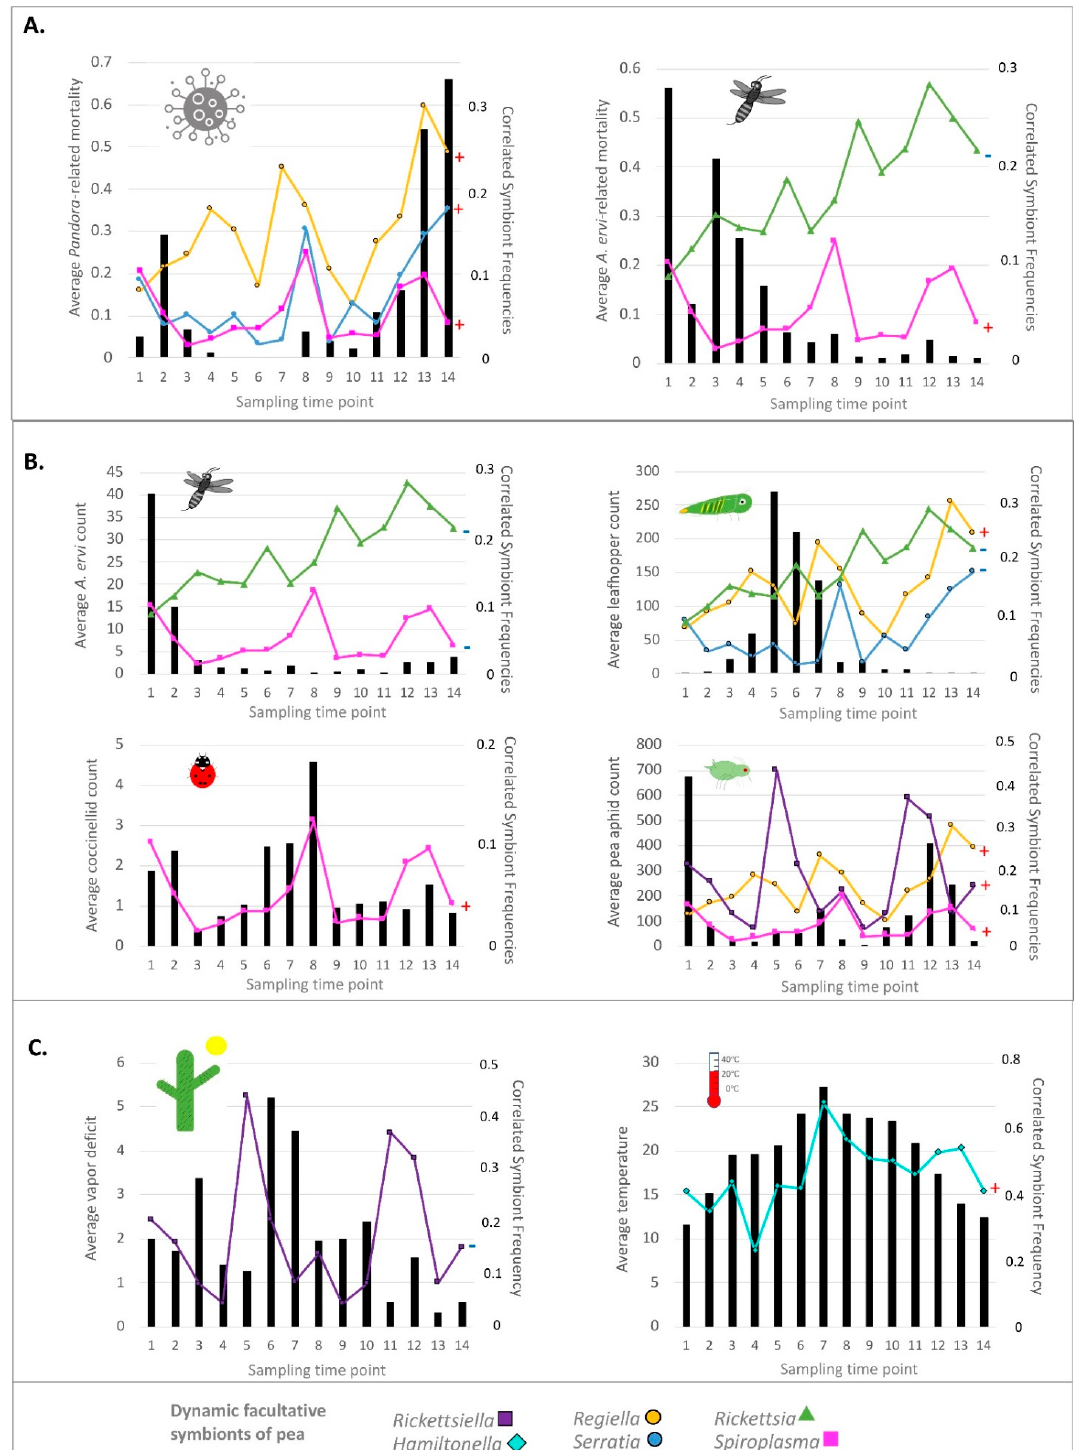
Figure 2. Correlations between the prevalence of facultative symbionts and environmental variables across the 2012 field season. Here we graph all significant results from our assessments of whether environmental variables (time t) predict symbiont frequency dynamics (time t), ascertained through diagnostic PCR. Each plot shows the data for the environmental variable (left y -axis) and prevalence/frequency of each symbiont (proportion of aphids infected) showing a correlation with the given variable (right y -axis). The directions of each correlation are denoted with a “ − ” or “+” to the right of each symbiont trendline. ( A ) Correlations with mortality due to Aphidius ervi parasitoids (ascertained by mummification)